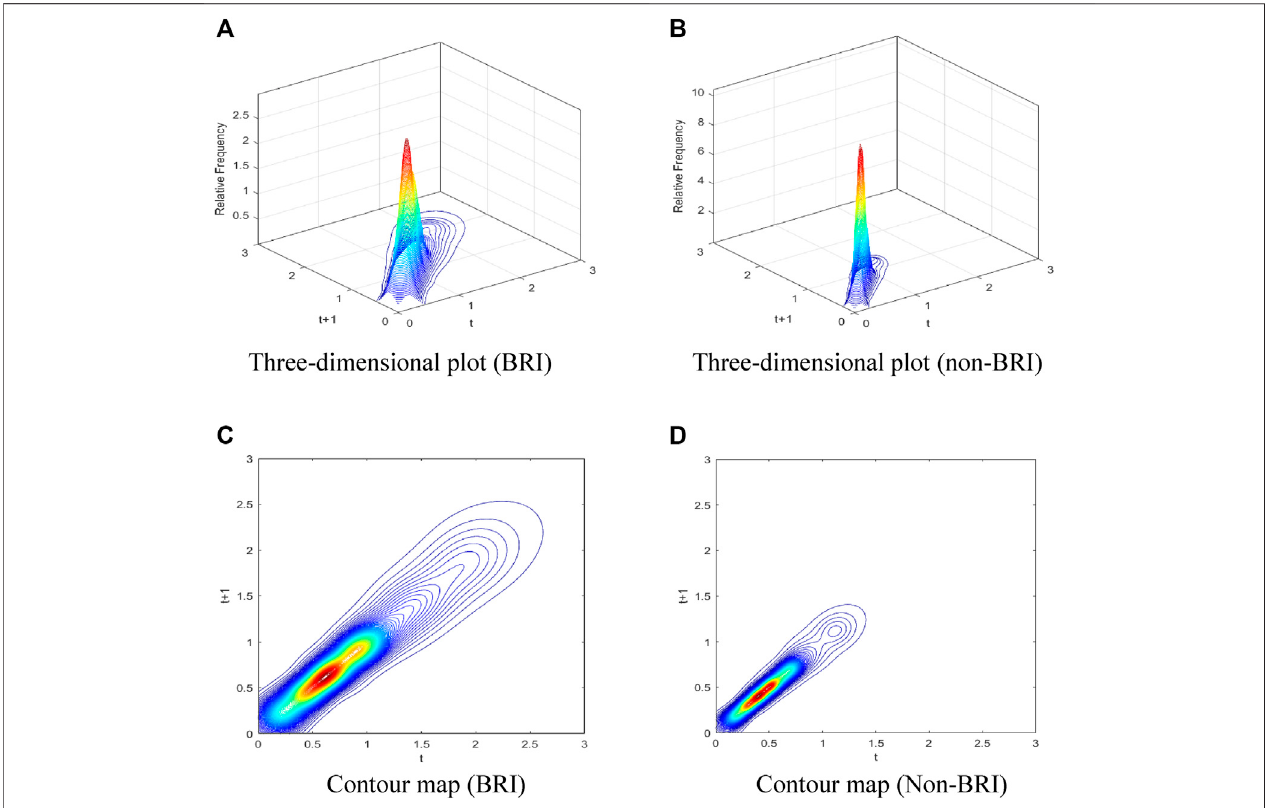
FIGURE 5 | Three-dimensional plot and Contour map of transitional probability kernel for carbon emission per PPP with yearly transitions from 1990 to 2014. (A) Three-dimensional plot (BRI). (B) Three-dimensional plot (non-BRI). (A) Three-dimensional plot (BRI) (B) Three-dimensional plot (non-BRI). (C) Contour map (BRI) (D) Contour map